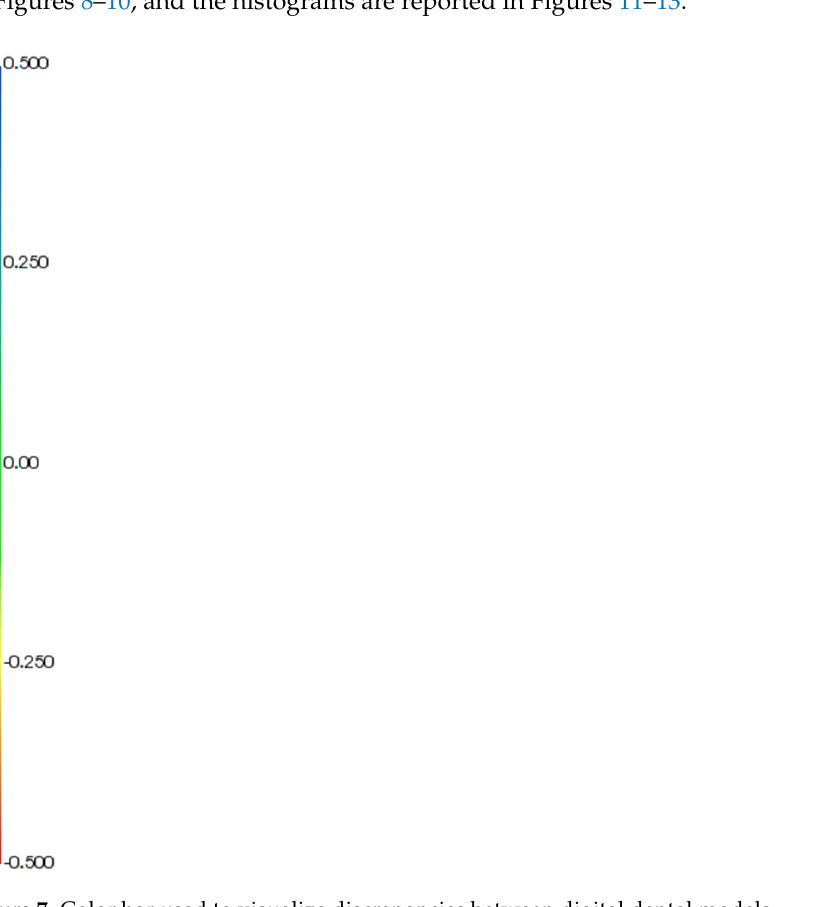
Figure 7. Color bar used to visualize discrepancies between digital dental models.